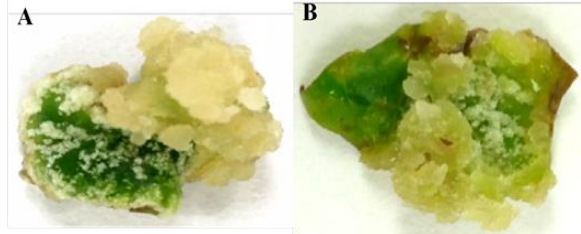
Figure 1: Callus induced on MS medium with A: 2.5 mg/l BAP and B: 3.0 mg/l